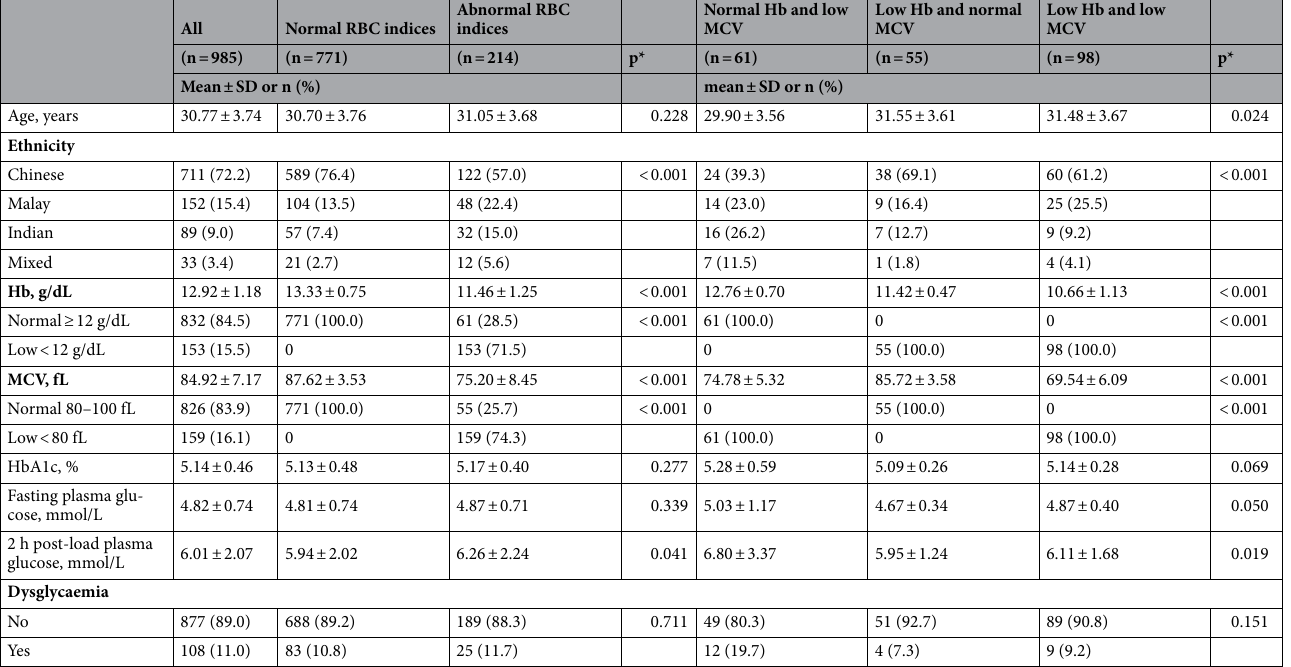
Table 1. Characteristics of women with normal and abnormal RBC indices from the S-PRESTO study. Hb haemoglobin, HbA1c glycated haemoglobin, MCV mean corpuscular volume, RBC red blood cells, SD standard deviation, S-PRESTO Singapore PREconception Study of long-Term maternal and child Outcomes. *By independent sample t test or one-way ANOVA for continuous variable, and Fisher’s exact test